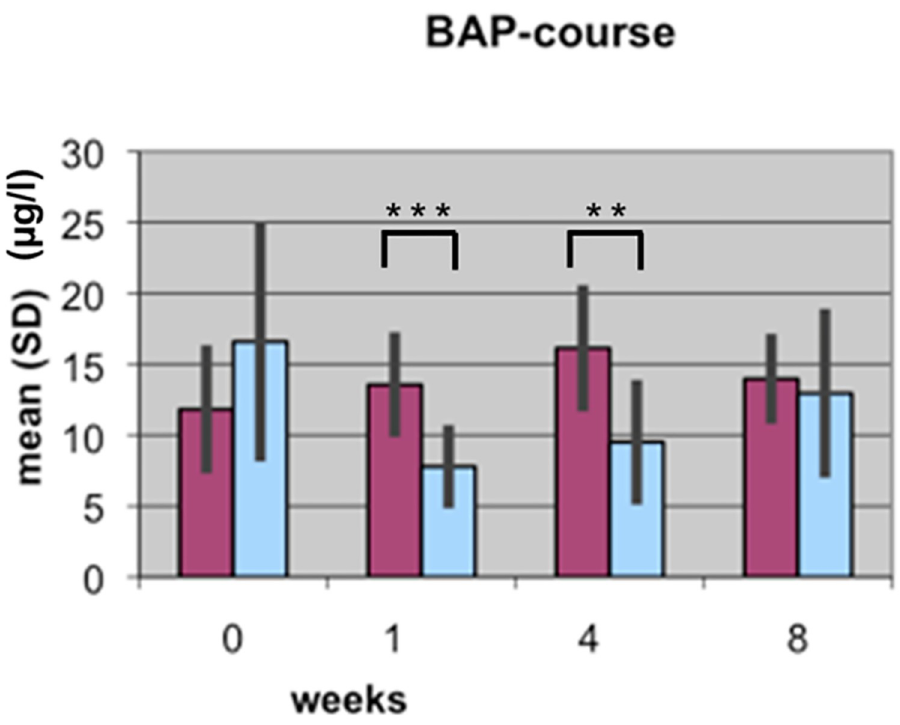
Fig 1. Course of BAP serum concentration ( µ g/l) during fracture healing of eight weeks in low BMD versus normal BMD patients. (Dark bars: low BMD group, light bars: normal BMD group). Statistics were performed using the software SPSS 11.0.0 (IBM Germany, Munich, Germany), Friedman test, Wilcoxon rank test and Mann-Whitney U tests were used. P � 0.05 was considered to be significant, p � 0.01 as very significant, and p � 0.001 as highly significant. Different levels of significance are marked by one to three